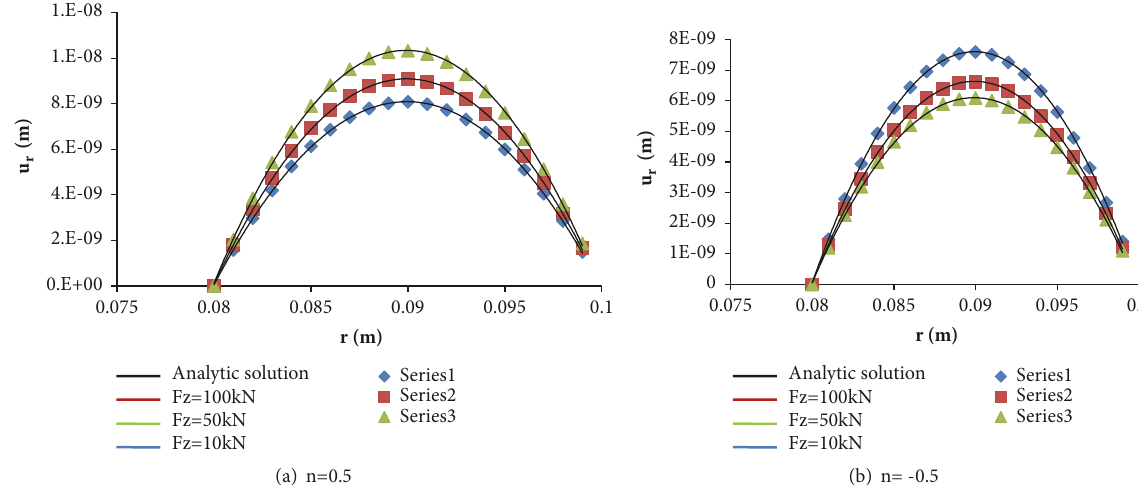
Figure 2: Displacement 𝑢 𝑟 as a function of the radial coordinate r : (a) for n=0.5 , (b) n=-0.5 .